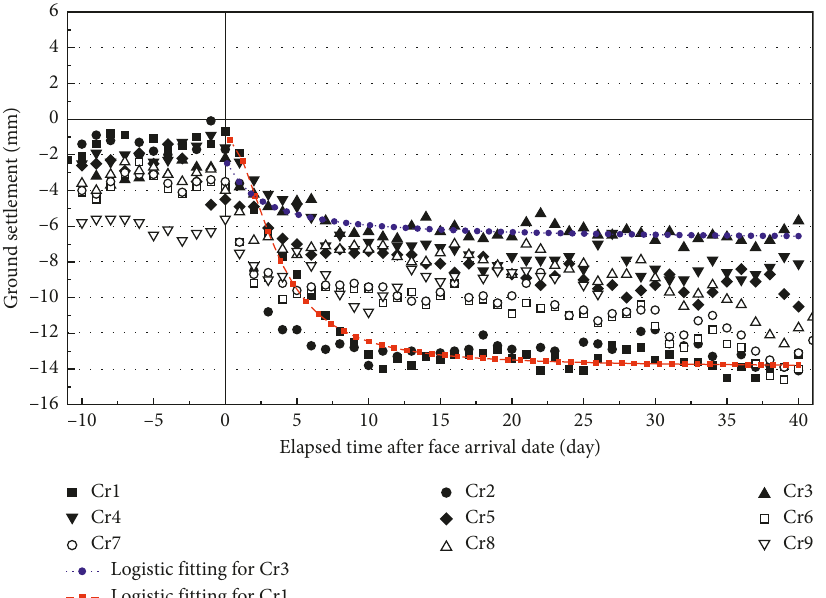
Figure 9: Variation of the settlement above tunnel crown with TBM drive sequences (up-track).